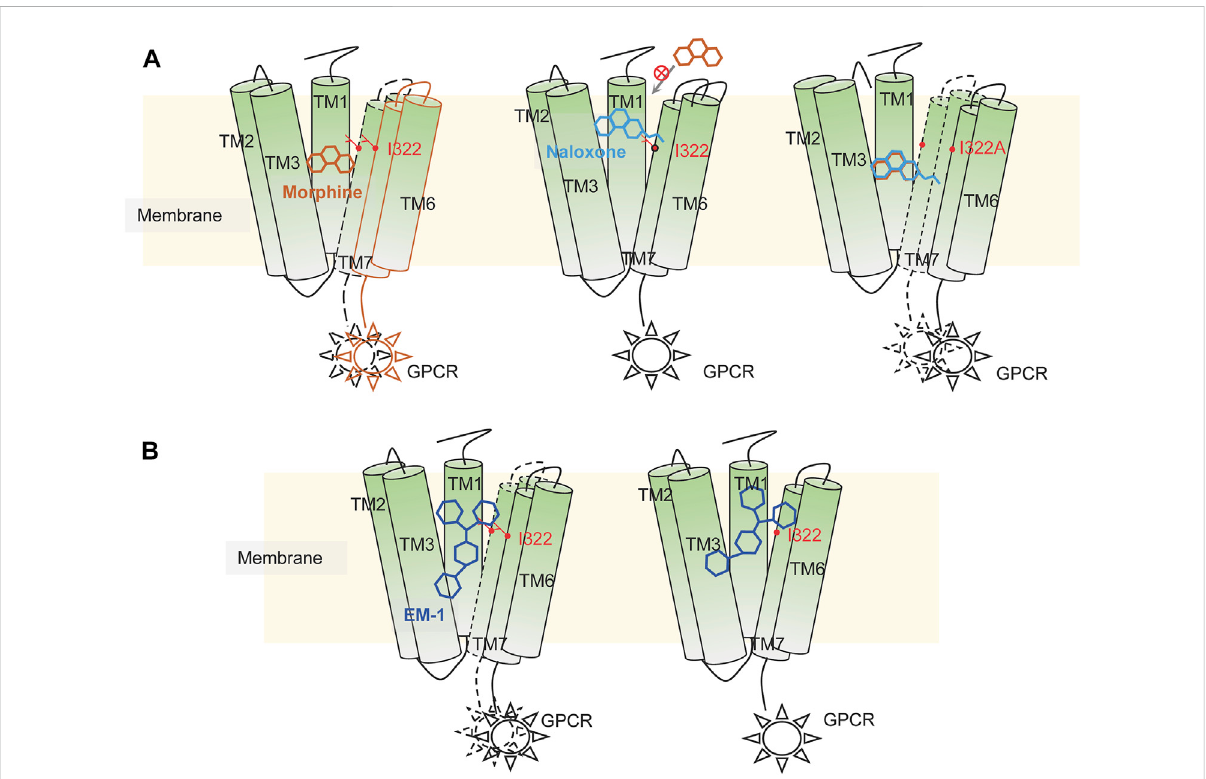
Illustration of possible mechanisms of dynamic recognition of morphine, EM-1 and naloxone by MOR. (A) possible mechanisms of MOR recognitionofmorphine(orange)andnaloxone(cyan).AppropriatebindingsiteslocateddeepwithintheMORbindingpocketarerequiredforMOR ’ s full activation, which is critical for the differential effects of morphine and naloxone on MOR. Residues distributed on the inner pocket of MOR prevent naloxone from entering thedeeper morphine-bindingsite due to additional ethylene, which makes naloxone acompetitive antagonist of MOR. (B) MOR response to EM-1. EM-1 does not readily adjust its conformation into the binding pocket due to its large size, whereas residues on the inner surface of the binding pocket can help EM-1 adopt the proper conformation and rapidly contact with them. Alterations in these residues could disrupt the activation of EM-1 to